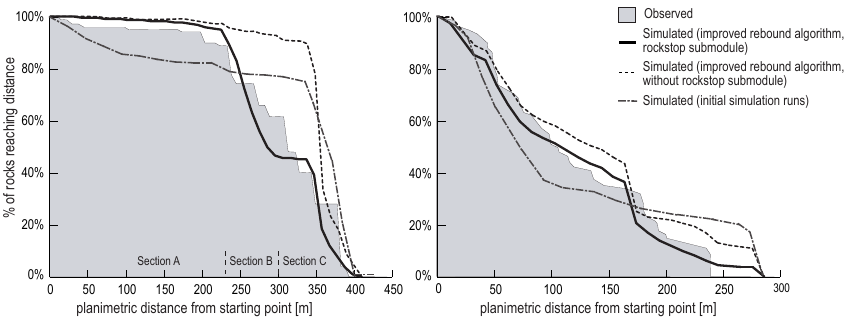
Fig. 4. Percentage of rocks that reach a certain distance at the unforested Site 1 (left) and forested Site 2 (right) in Vaujany. The filled area denotes the observed values, the bold line shows the simulation results ( N =10000 rocks) of the final model version. The dash-dot lines indicates the initial simulation runs, the dashed lines results with improved rebound algorithm but without the rockstop